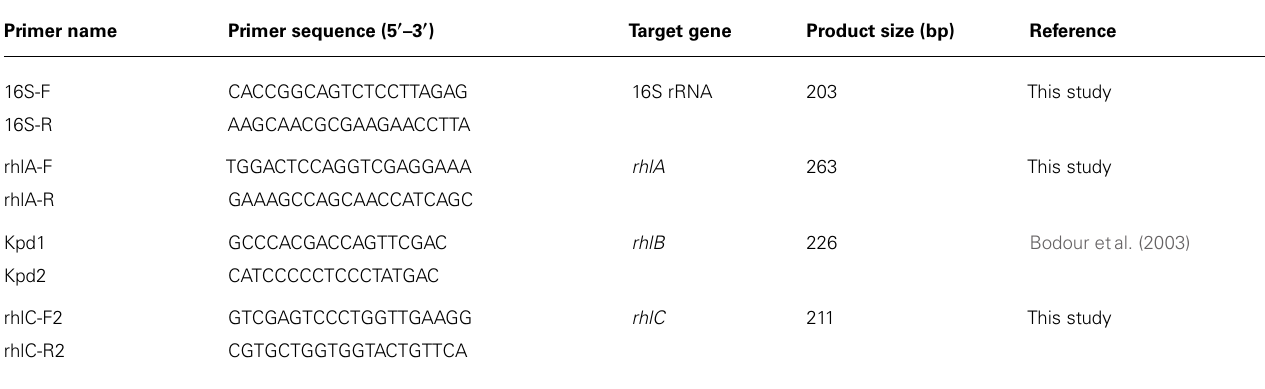
Table 1 | Primers used in this